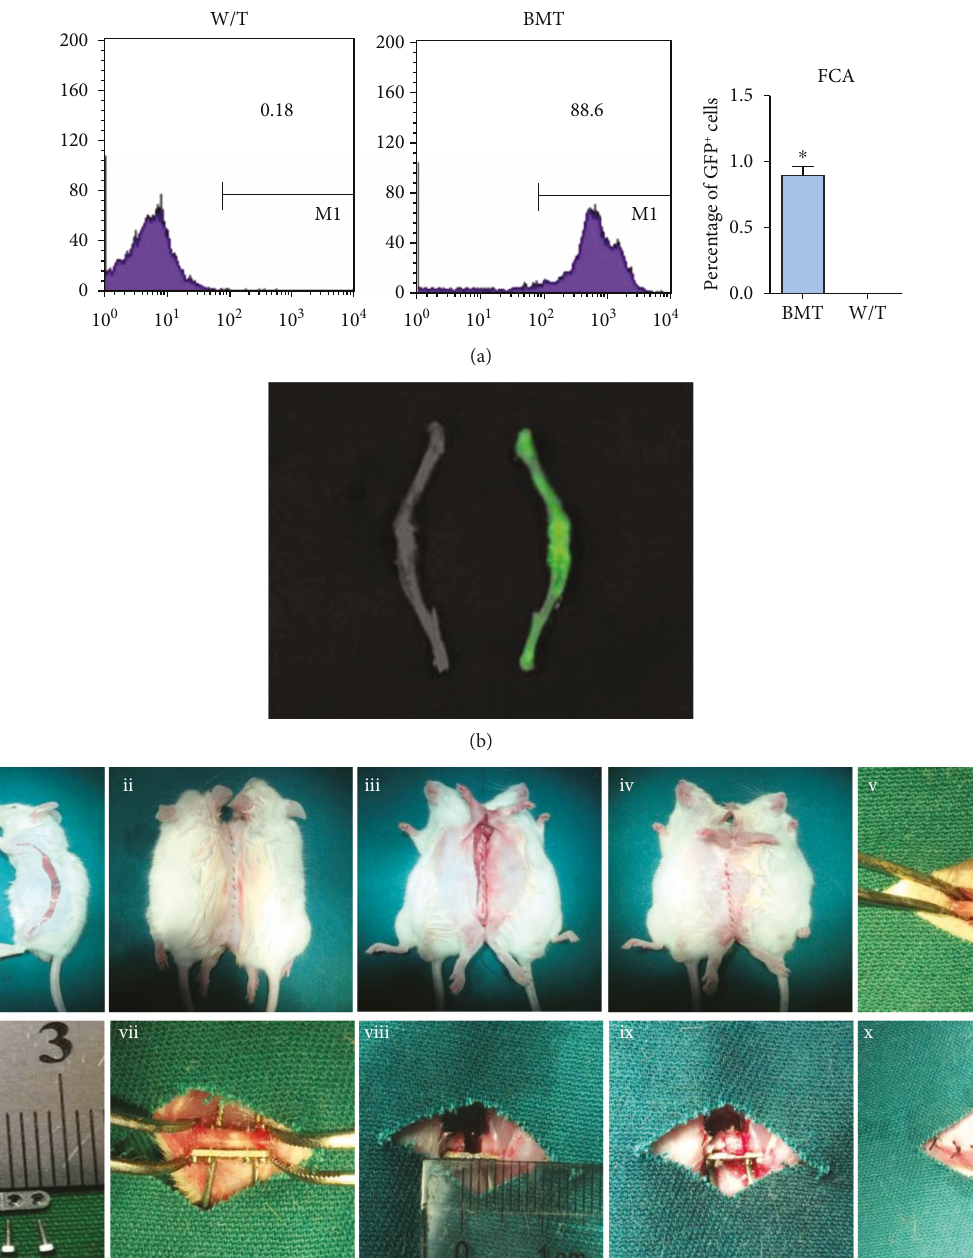
Figure 1: Bone marrow transplantation (BMT) and the surgical procedures of complex animal models. (a) At 6 weeks, GFP + cells in bone marrow of BMT and wild-type mice were detected by fl ow cytometry. The numerical value represents the mean percentage of GFP + cells in each group ( n = 3 ). (b) Bioluminescence image of femur and tibia. Green fl uorescence intensity was observed between wild-type (left) and BMT (right). (c) The parabiotic mouse model was fabricated (i-iv) and two weeks later, a critical-sized bone defect was created